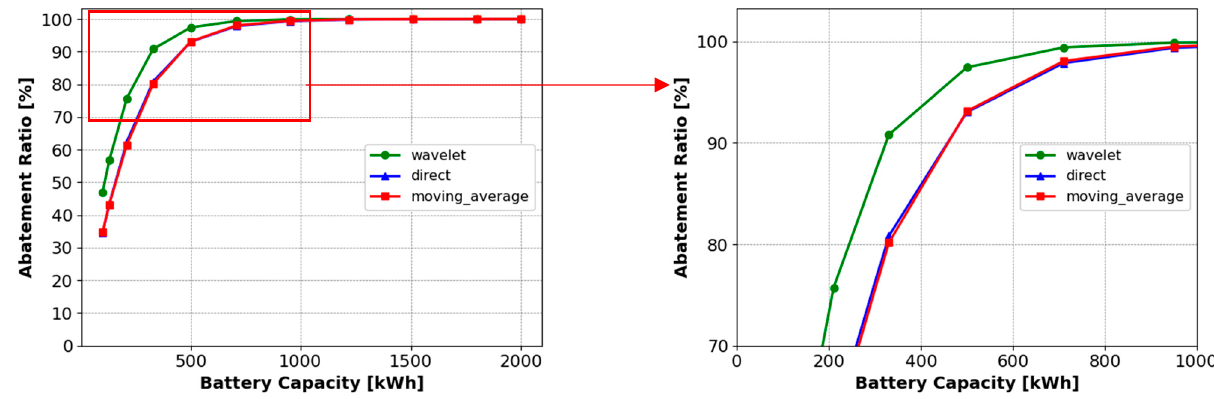
Figure 15. Abatement Ratio vs. Battery Capacity for the considered power smoothing algorithms.